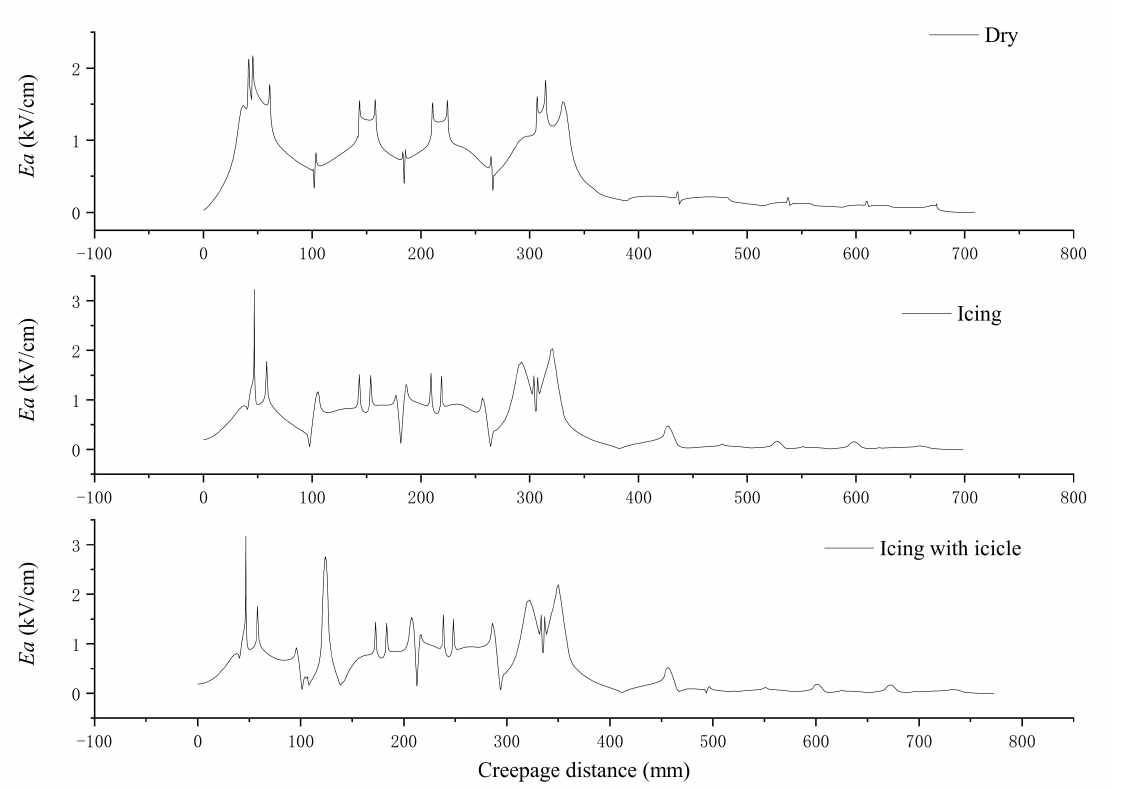
Figure 6. Electric field distribution of the left